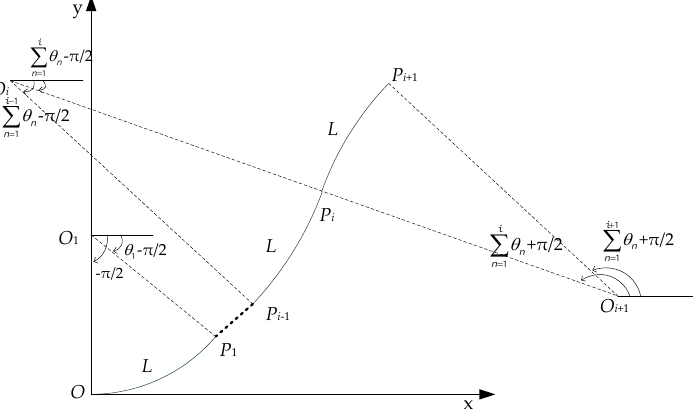
Figure 4. The schematic diagram of circular arc curve fitting method.